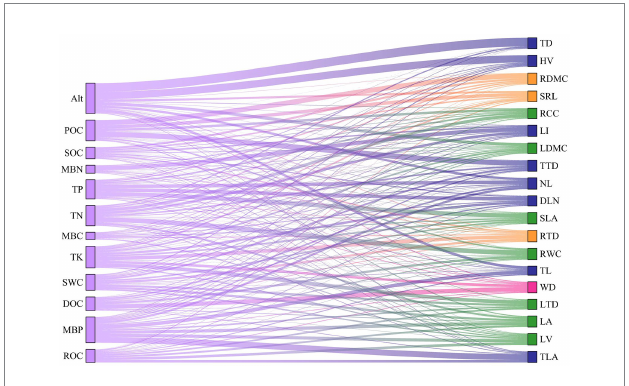
FIGURE 9 The contribution of each environmental factor to the functional